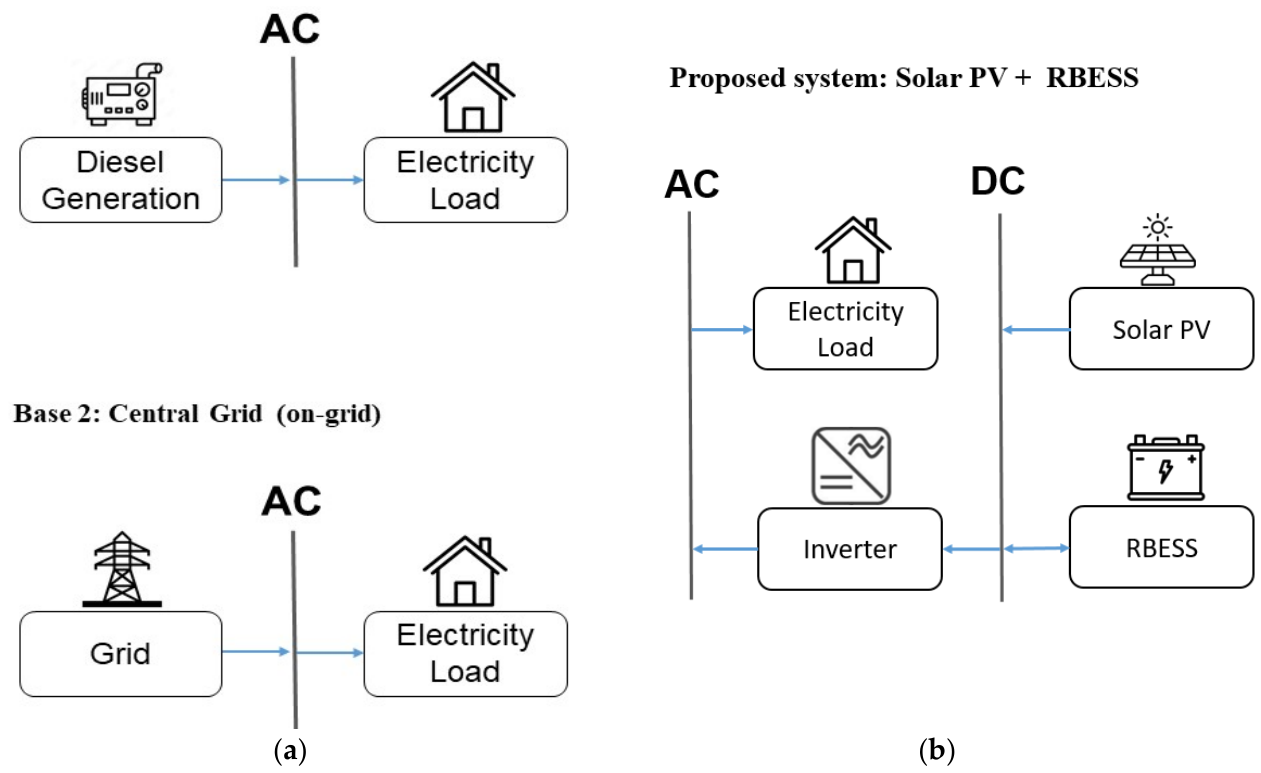
Figure 3. System c onfiguration:( a ) base system; ( b ) proposed system. Figure 3. System configuration:( a ) base system; ( b ) proposed